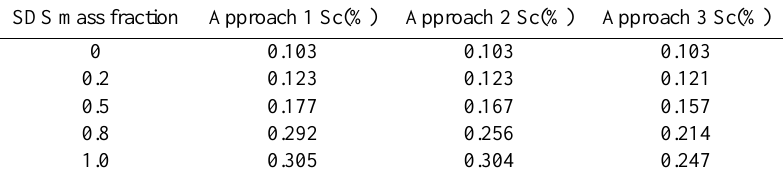
Table 2. Critical supersaturations for K¨ohler curves calculated with different mass fractions of SDS and NaCl. Approach 1 shows predictions using equations presented in this study. Approach 2 are the results of Sorjamaa et al. (2004). Approaches 1 and 2 consider combined effects on the Raoult and Kelvin terms. Approach 3 are the results of Li et al. (1998) who only considers the impact on surface